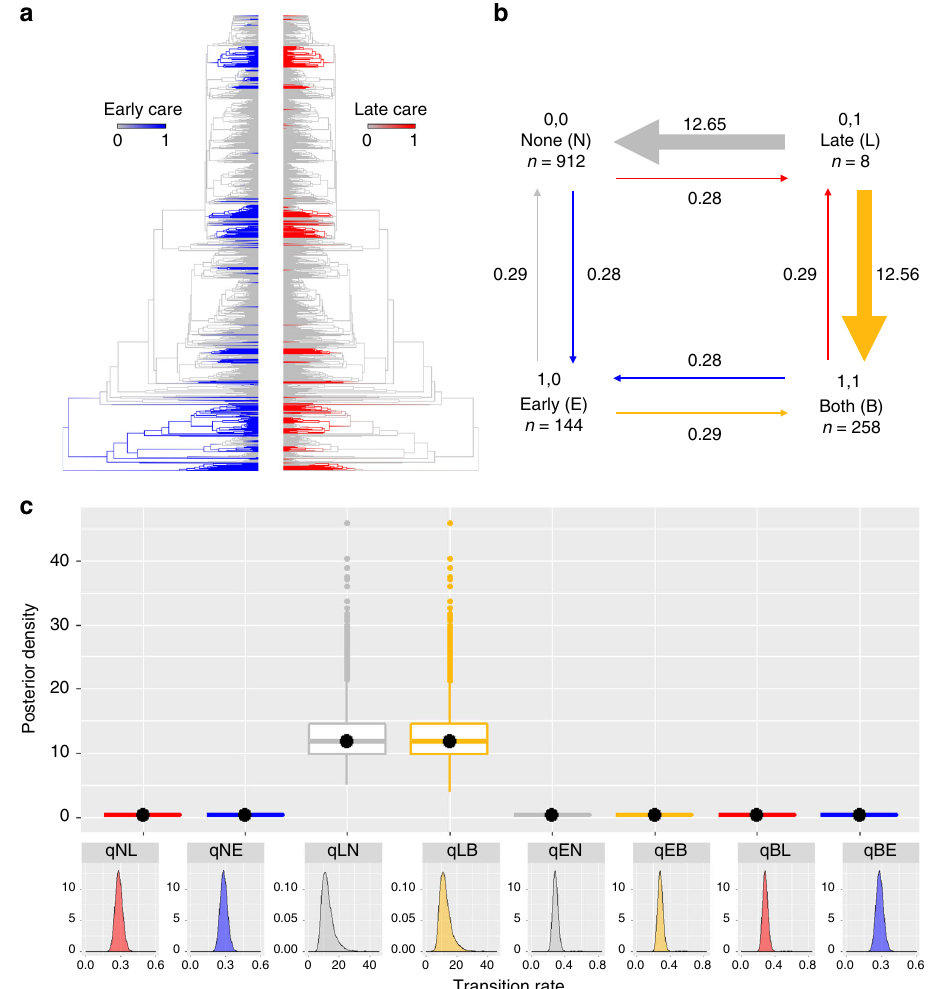
Fig. 3 The correlated evolution of early and late care. a Early care (blue) and late care (red) plotted on the phylogeny using stochastic character mapping with the R package phytools 73 . b Summary diagram of the transition rates across the four combinations of character states from the RJ Discrete Dependent model of evolution. The sample sizes for each combination of character states are reported; the arrows are scaled to re fl ect the magnitude of mean transition rates from the posterior distribution, with the mean value also indicated. c Posterior distributions of the transition rates from the RJ Discrete Dependent model of evolution are shown as box plots for comparison and as posterior density plots for each transition rate alone. The central black dot in the box plots indicates the median, the box the upper and lower quartiles, the vertical lines the 95% credible intervals of the posterior distributions, and the fi lled dots beyond the lines indicate outlier estimates. Transition rates among character states in b and c are indicated as follows: no care to late only care (NL, red); no care to early only care (NE; blue); late only care to no care (LN; grey); late care to prolonged care, i.e. both late and early (LB; yellow); early only care to no care (EN, grey); early only care to prolonged care, i.e. both late and early (EB; yellow); prolonged care to late only care (BL; red); prolonged care to early care (BE;